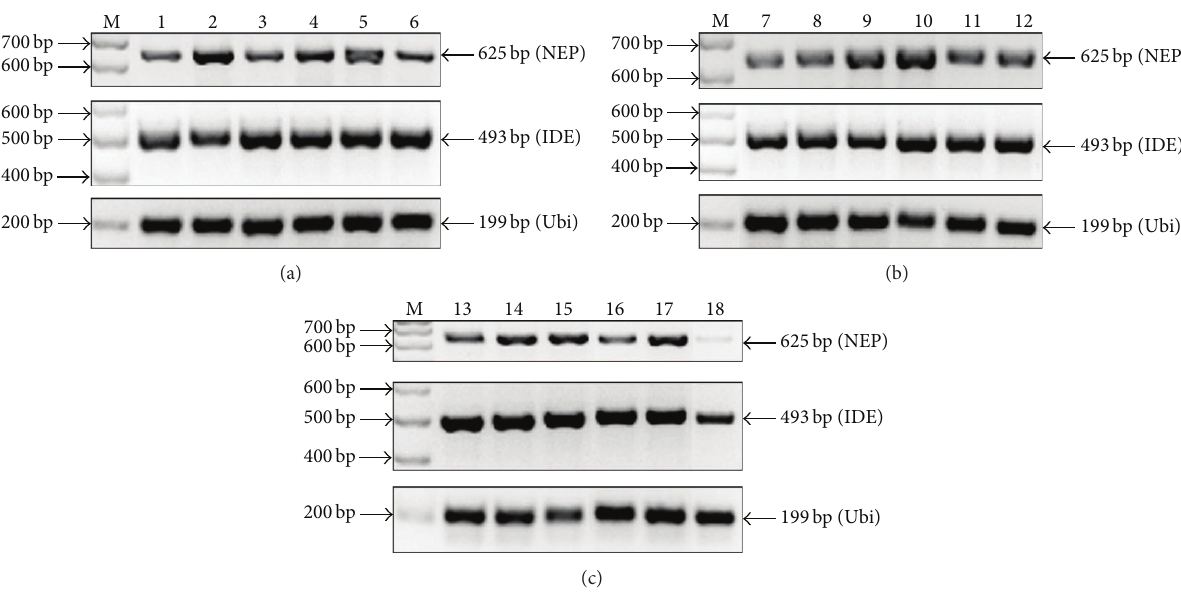
Figure 1: Agarose gel electrophoresis of RT-PCR of NEP, IDE, and Ubi arranged by groups ((a) young, (b) aged-CU and (c) aged-CI). Amplicons of NEP cDNA (625 bp band) in young (a) and aged-CU (b) animals showed considerable intragroup variability; in contrast in aged-CI dogs (c), there are lower levels of NEP with less variability. IDE amplicons (493 bp band) present high intensity of band with similar levels in all animals. Ubi was included as an internal